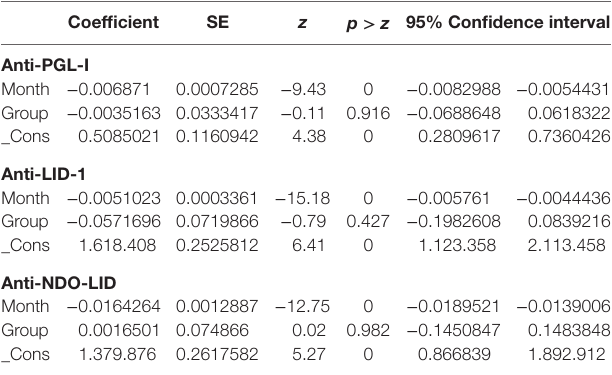
TaBle 2 | Results of adjusted mixed multilevel regression analyses of anti-PGL-I, anti-LID-1, and anti-NDO-LID serology overtime in leprosy patients treated with R-MDT and U-MDT.